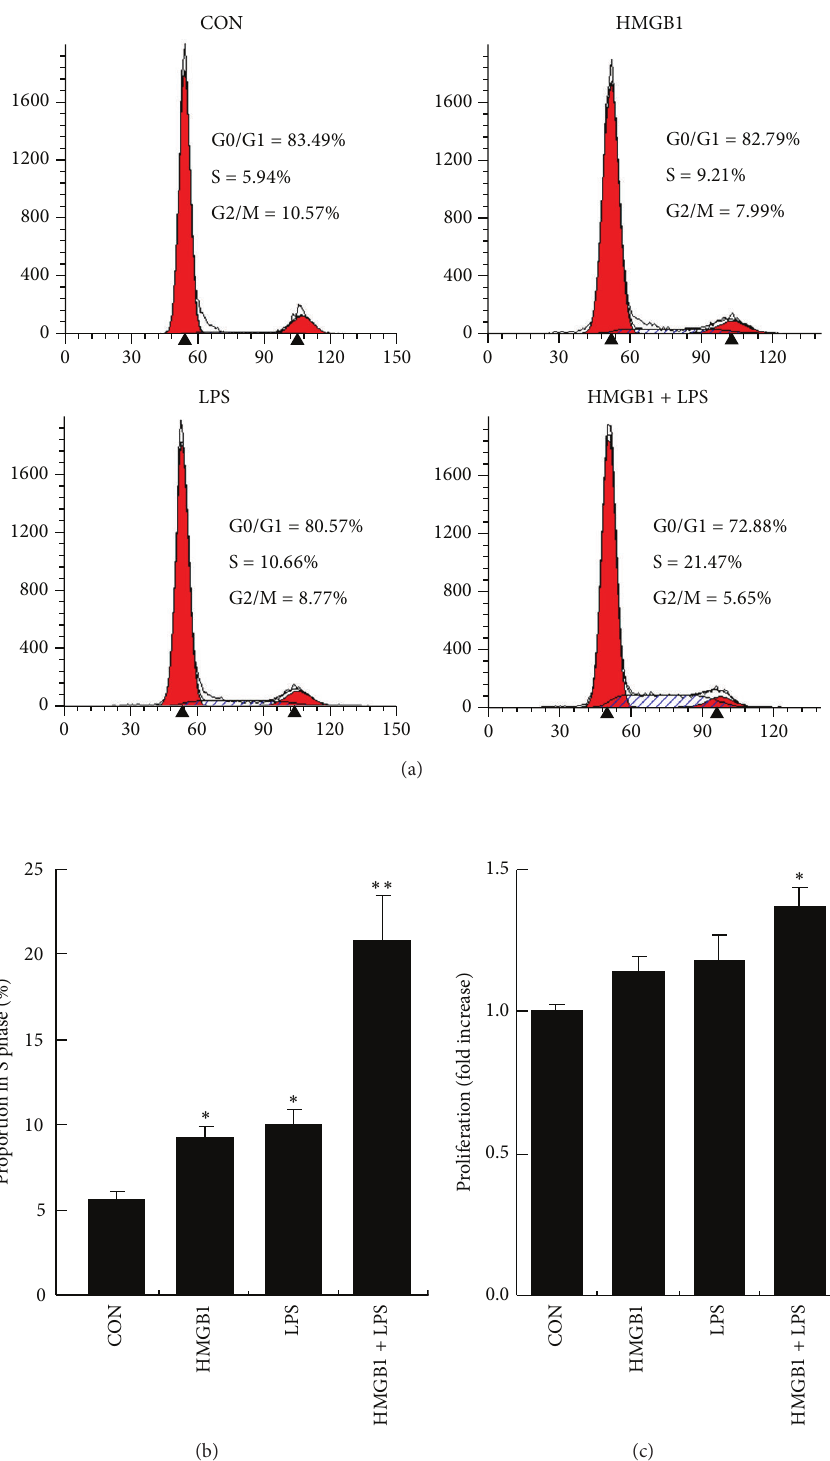
Figure 1: HMGB1 acted in synergy with LPS to stimulate the proliferation of SF. CON: control; HMGB1: high-mobility group box 1 protein; LPS: lipopolysaccharide. Cultured synovial fibroblasts (SF) were isolated from synovium obtained from patients with rheumatoid arthritis (RA): and cultured in vitro for 3–6 passages. SF were incubated with 10 ng/mL of LPS and/or 100 ng/mL of HMGB1 for 24 h. (a) and (b) SF were stained with propidium iodide for flow cytometric analysis. The percentages of cells in the G1, S, and G2/M phases of the cell cycle were determined using ModFit LT software. Representative histograms (a) and the percentages of the cells in S phase (b) were shown. (c) Cell proliferation was analyzed using commercially available Cell Counting Kit-8. Data are expressed as mean ± SD ( 𝑛 = 3 ). ∗ 𝑃 < 0.05 and ∗∗ 𝑃 < 0.01 compared with control (unstimulated SF). Results shown are representative of 4 independent